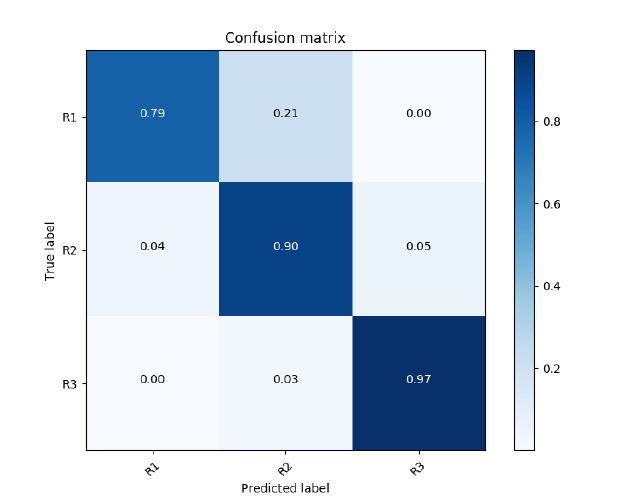
Figure 7. Confusion Matrix for the KNN algorithm trained on the training data, with optimized parameters for the training data subject only to smoothing operation, and validated with the test data subject to both imputation and smoothing procedures.